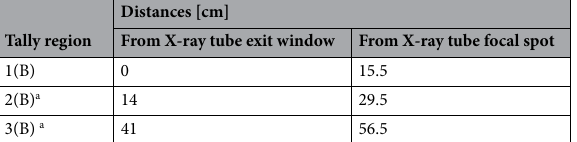
Table 5. Typical distances of the 3 detectors used in experiments and simulations in order to irradiate the cells placed as described in Fig. 2. a Tally regions 2(B) and 3(B) are related to the Petri dish positions. Tally